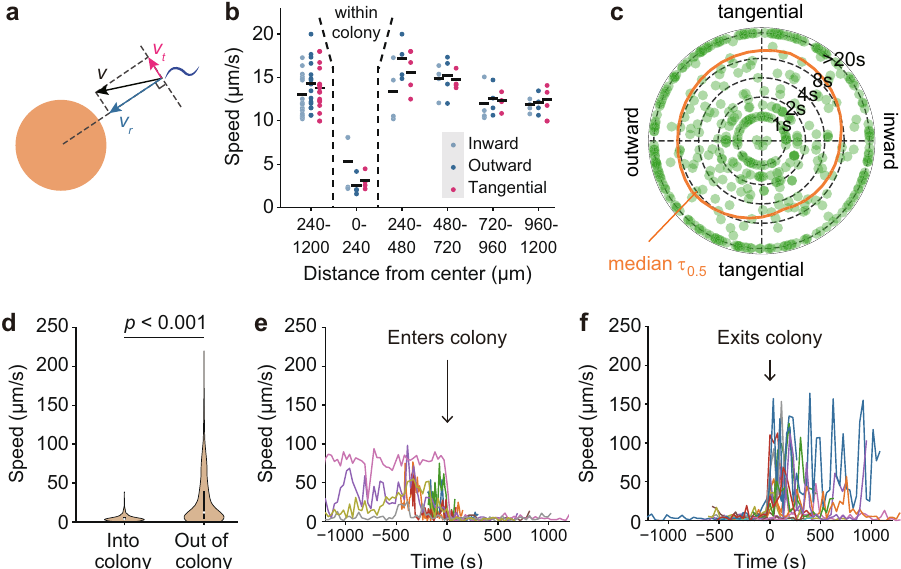
Fig. 3 Chemotaxis vs. random capture. a Schematic of breaking down a worm ’ s velocity into radial and tangential components. A colony is shown by the orange disc, and a worm by the blue curl. The radial component of the velocity is shown as a blue arrow, and the tangential component as magenta arrow. b Measured radial and tangential velocities for worms overall and at various distances from a colony. Most of the worms in the 0 – 240 µ m bin were in colonies. The data for worms at distances outside of this bin are shown both separated by bin (240 – 480, 480 – 720, 720 – 960, and 960 – 1200 µ m) and in aggregate (240 – 1200 µ m). Data points are average velocities for worms in each bin, for each of 4 independent experiments done on 2 days. The total number of velocities averaged together for each data point ranged from 10,604 to 45,530. Velocity components were averaged for each colony at each distance before statistical analysis. A two-sided, Shapiro test failed to reject normality in all data bins; p -values were 0.74 – 0.99. p values for comparison of the inward, outward, and tangential components of the velocities were calculated by two-sided Student ’ s t -test and ranged from 0.23 to 0.91 for the four bins between 240 and 1200 μ m. c The time for the cosine similarity to drop to 0.5 ( τ 1/2 ) for individual worms with different initial orientations. On this polar coordinate representation, the radius denotes the τ 1/2 and the angle denotes the angle between the worm ’ s initial trajectory and the center of the colony, with due east being 0°. Median τ 1/2 values were calculated for worms binned into six wedge-shaped angular regions, and a smooth spline curve was fi tted to the median values (orange). d Violin plots of the speeds of worms in colonies and outside of colonies. The black bars span the 25 – 75th percentiles. Open circles indicate median values. The Wilcoxon rank-sum test p -value is shown (two-sided; n = 769 in-colony; 1378 out-of-colony, p = 5 × 10 − 91 ). e , f Examples of worms slowing down upon entering a colony ( e ) and speeding up upon exiting a colony ( f